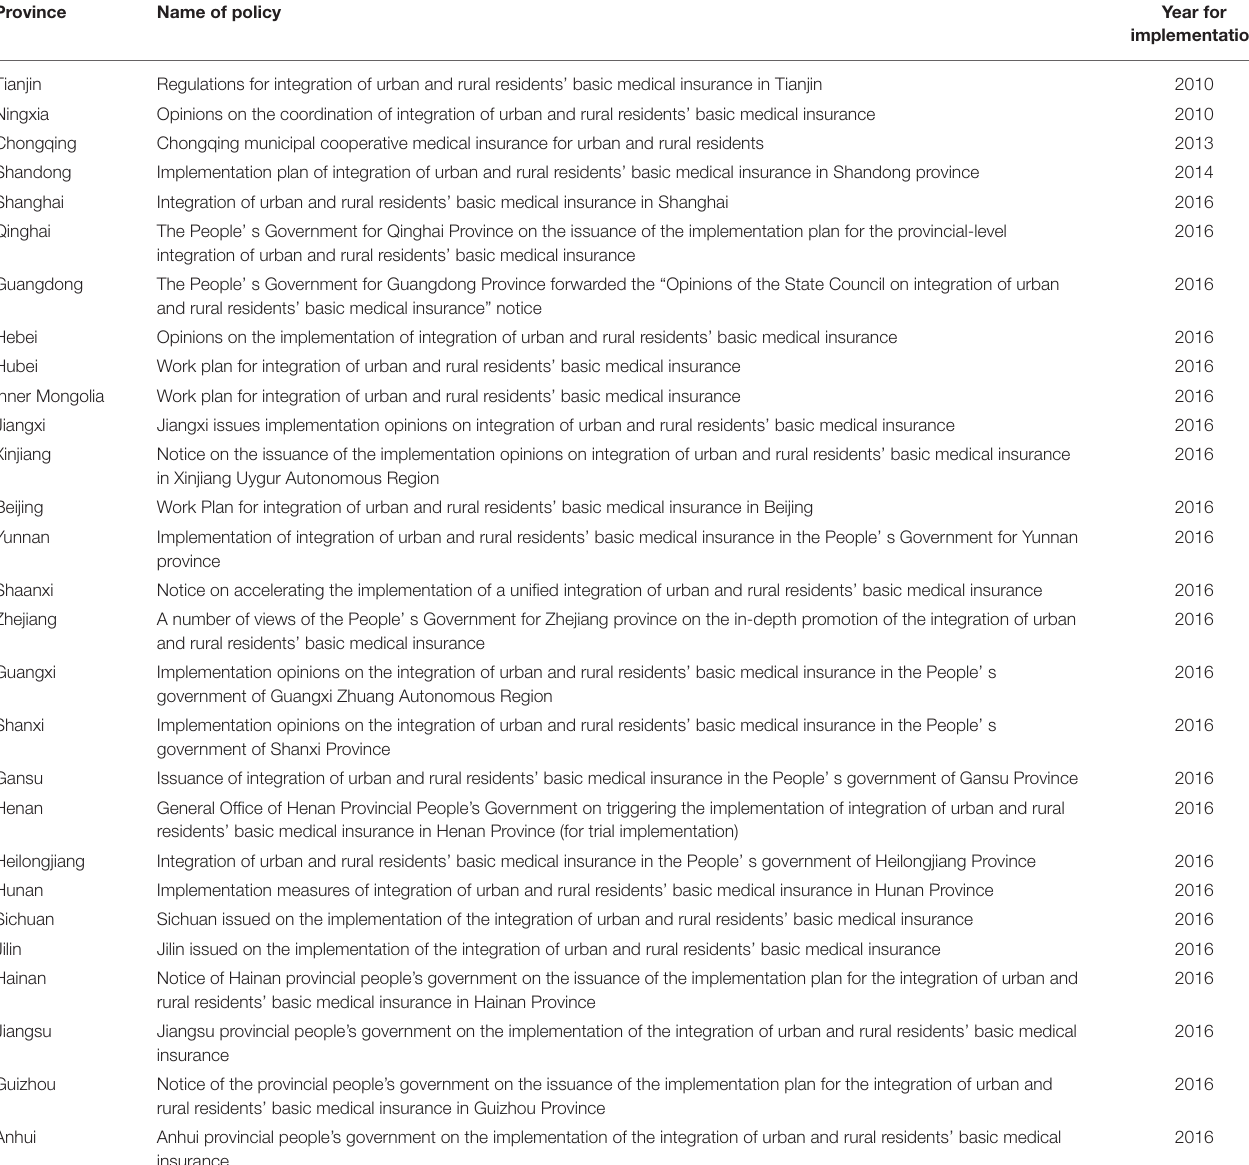
TABLE 1 | The basic situation of urban and rural residents’ basic medical insurance in China.